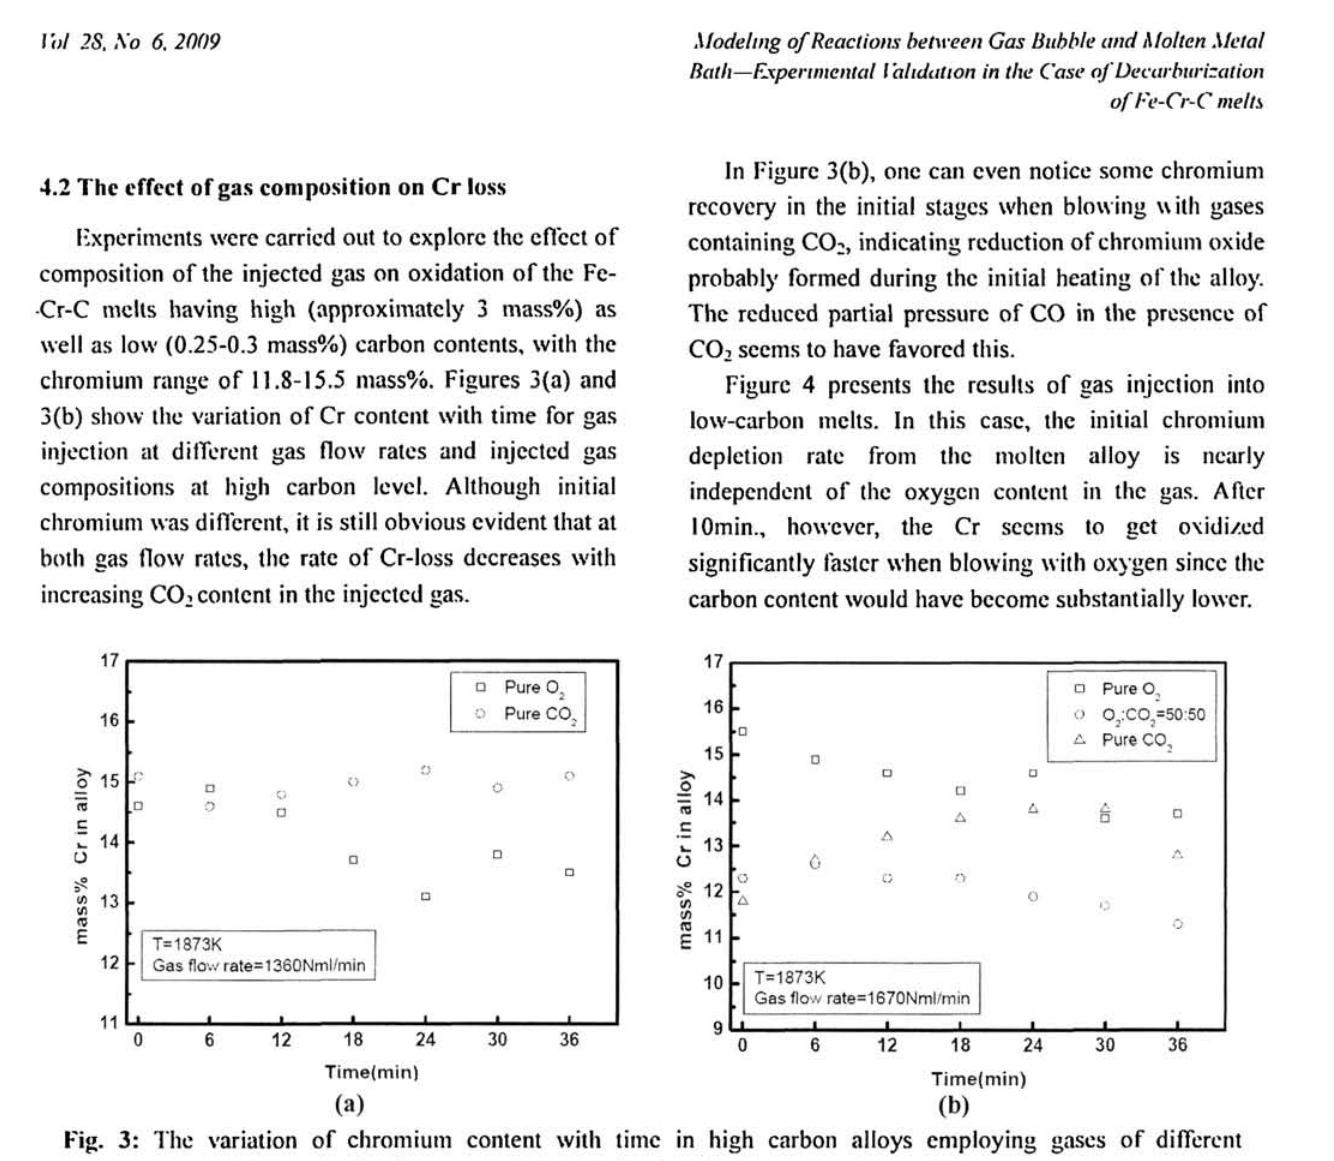
Fig. 3: The variation of chromium content with time in high carbon alloys employing gases of different compositions, (a) Injection rate =1360Nml/min; (b) Injection rate =1670Nml/min.